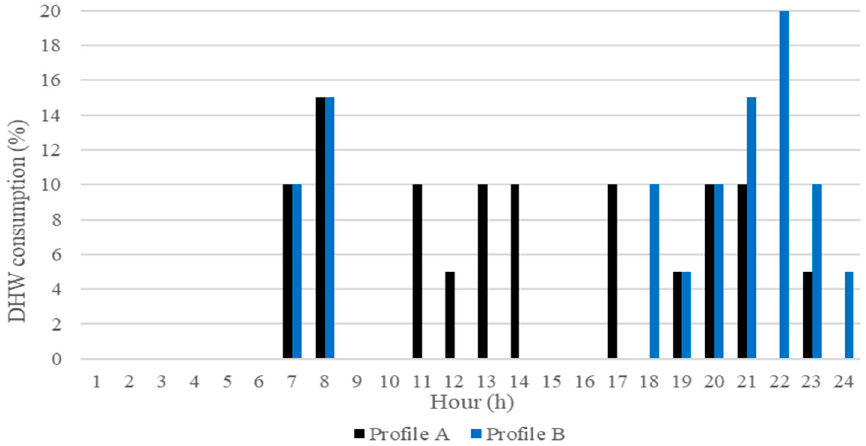
Figure 11. Hourly distribution of DHW consumption for two different daily profiles of the water use.